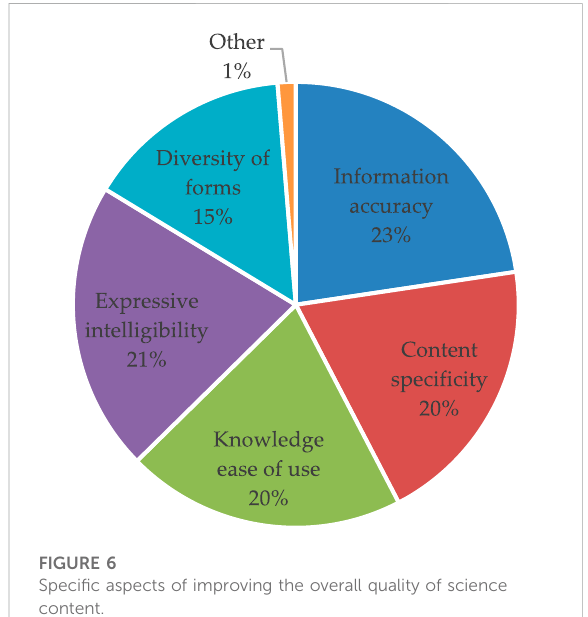
FIGURE 6 Speci fi c aspects of improving the overall quality of science